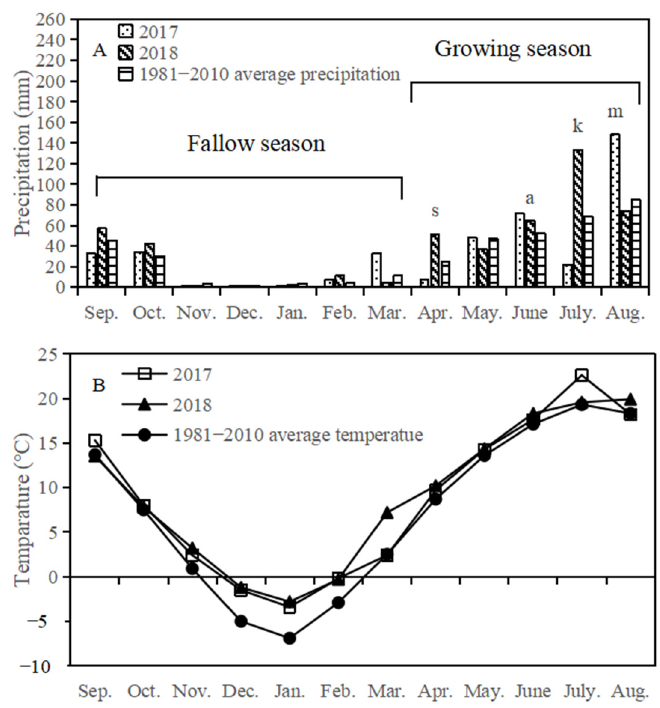
Figure 1. Monthly precipitation ( A ) and temperature ( B ) in 2017, 2018 and 1981–2010 at Dingxi station, China. The letters indicate sowing ( s ), anthesis ( a ), kernel ( k ), and maturity ( m ). The growth of the oilseed flax was divided into five stages: seedling, budding, anthesis, kernel and maturity stages.